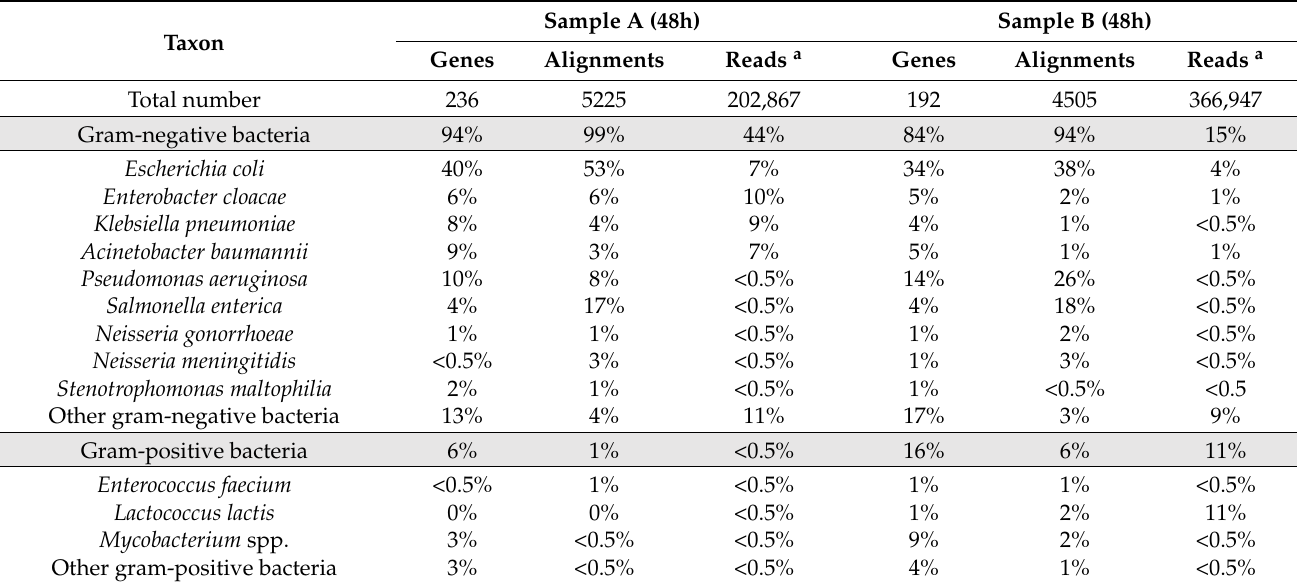
Table 7. Distribution of ARGs through species, a —reads of single